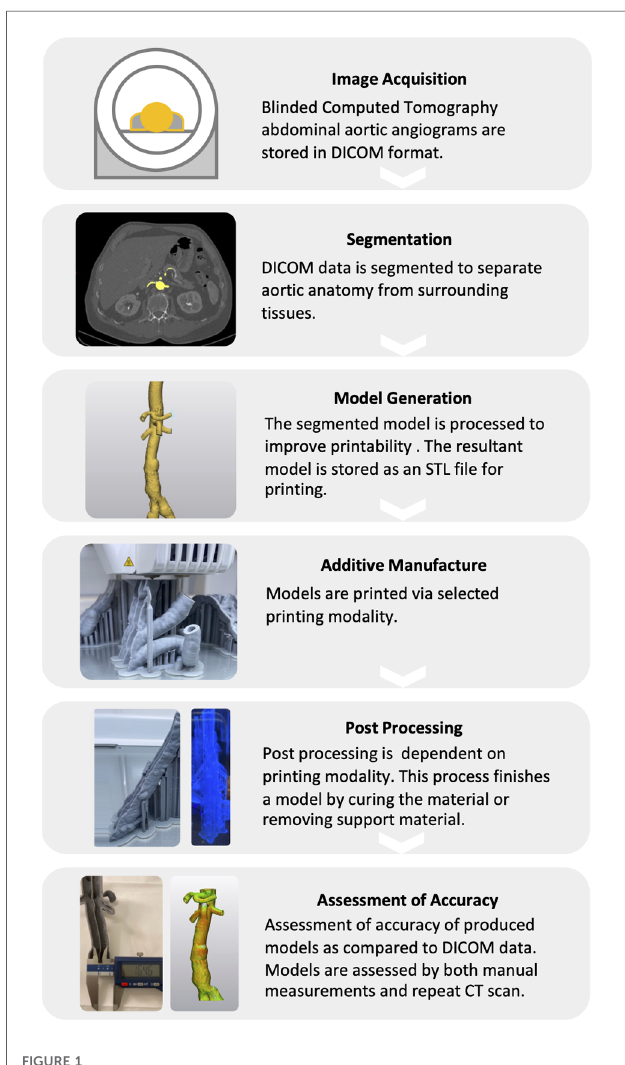
FIGURE 1 Schematic work fl ow for the medical 3D-printing of vascular anatomical models. The M3DP of anatomical models encompasses a multi-step procedure including image acquisition, digital anatomical segmentation, mesh re fi nement, 3D printing, and